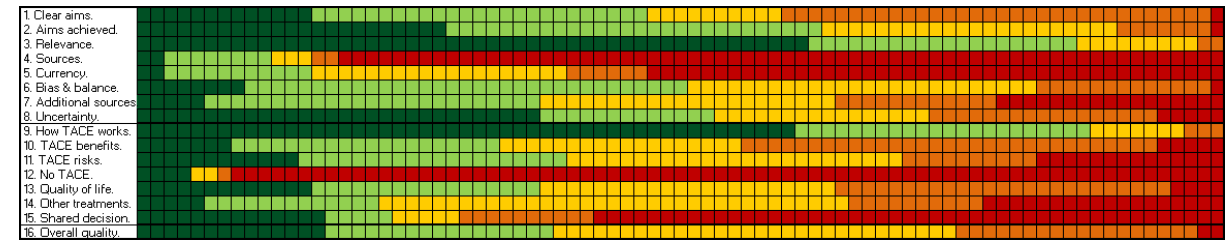
Figure 2. Distribution of scores on each component of the DISCERN score. Scores range from 1 (definitive no, red) to 5 (definitive yes, dark green). TACE: transarterial